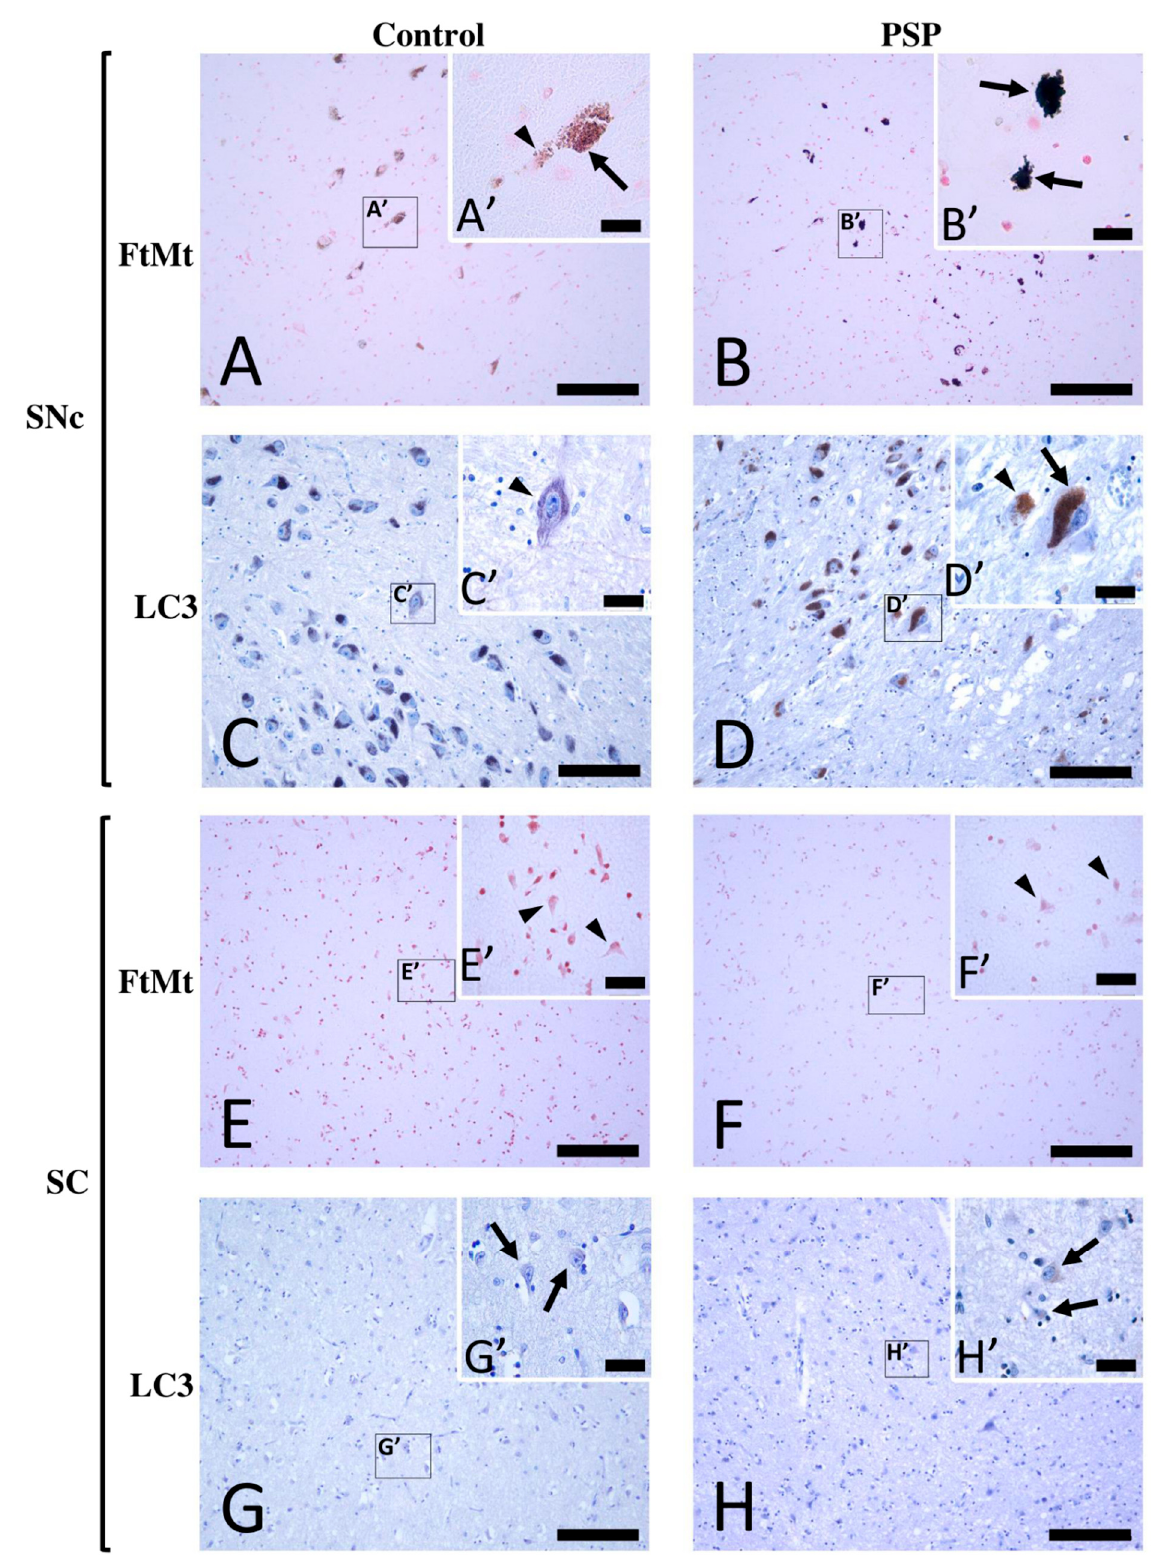
Figure 1 . Immunohistochemistry for FtMt and LC3 in the SNc and SC of a control case (control-2) and a PSP patient case (PSP-4). ( A ) FtMt-IR in a control case’s SNc and ( A ′ ) high-magnification image of a neuromelanin-containing neuron in boxed area in ( A ); the arrowhead indicates weak brown dotty neuromelanin deposits, while the arrow indicates puncta with strong dark FtMt-IR. ( B ) FtMt- IR in a PSP case’s SNc and ( B ′ ) high-magnification image of the boxed area in ( B ); arrows indicate